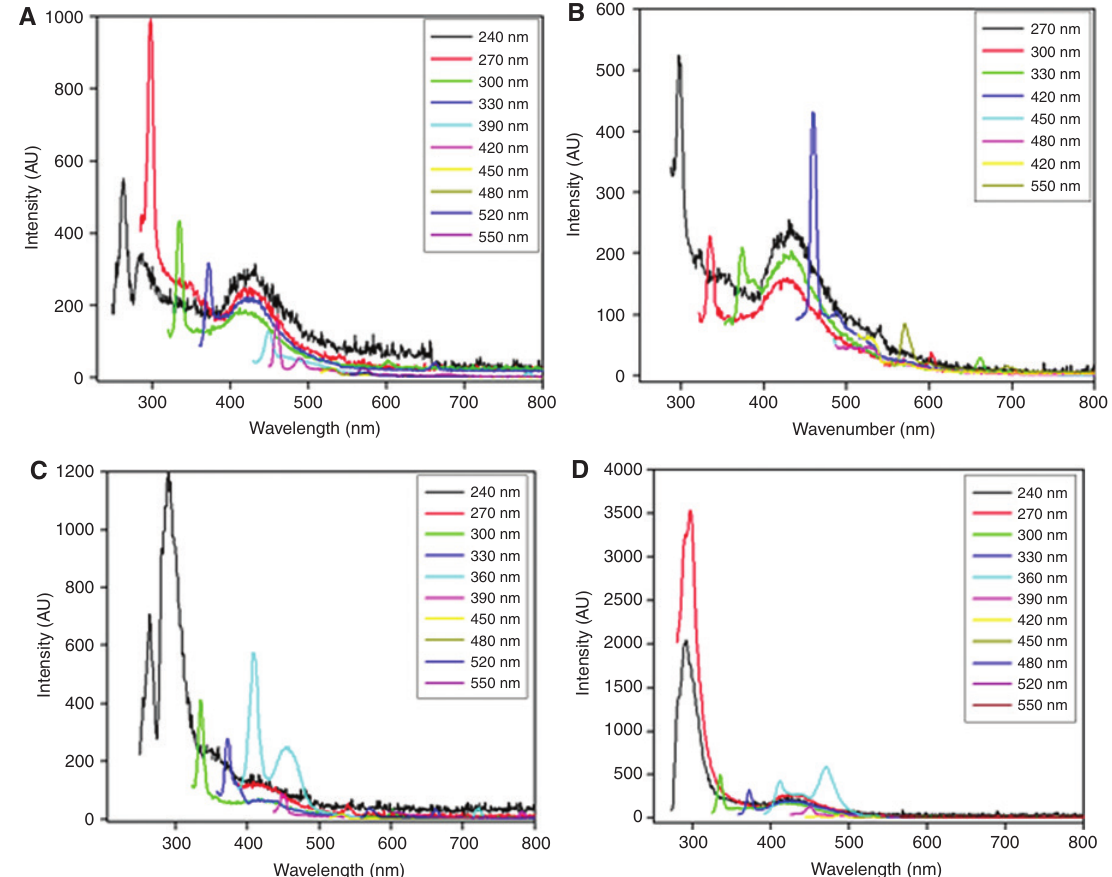
Se nanoparticles capped with (A) green tea, (B) glucose, (C) ascorbic acid and (D) Figure 2: Emission spectra of Ag 2